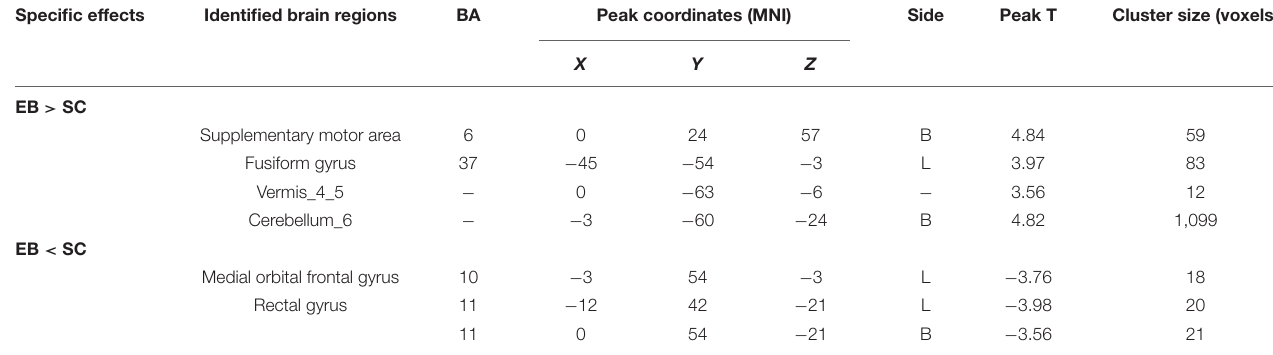
TABLE 2 | Brain regions with significant differences in DC values between the EB and SC groups (Gaussian random field-corrected cluster-level P < 0.05). Specific